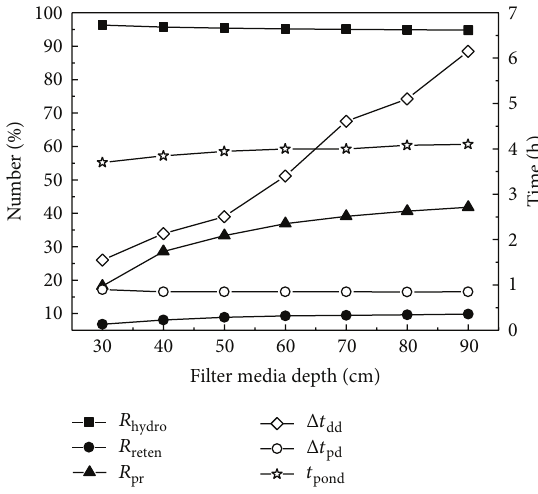
Figure 6: Hydrologic performance of bioretention measures under different filter media